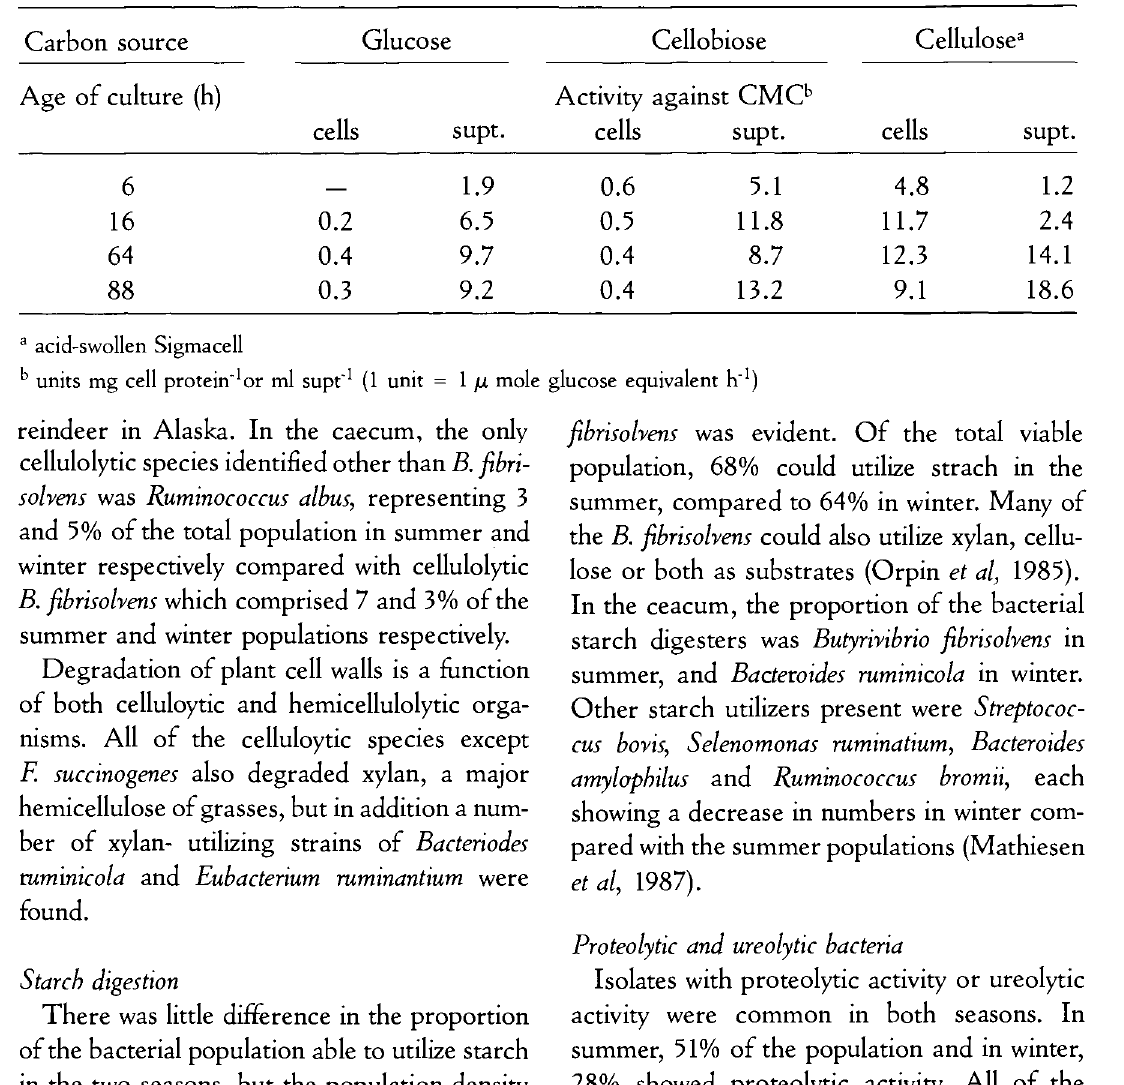
Table 6. Distribution of cellulase (CMCase) activity in cultures of Butyrivibrio A46 Carbon